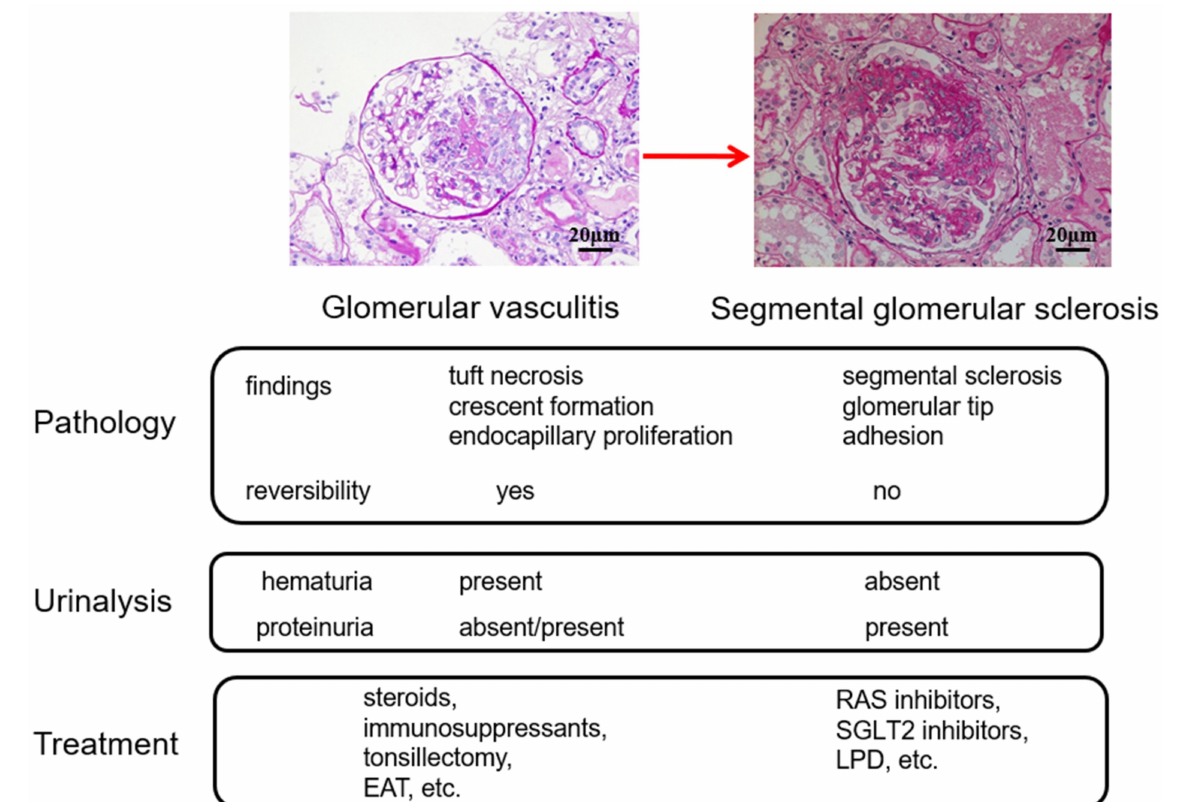
Figure 14. Treatment options based on the Glomerular vasculitis related pathologic conditions of IgAN. As Glomerular vasculitis and segmental glomerular sclerosis (SGS) differently coexist in IgAN, the key point of IgAN treatment is to estimate the element of Glomerular vasculitis and the element of the SGS from the findings of renal biopsy and urinalysis in each patient. It is also important to consider the limitation of histological assessment of Glomerular vasculitis by a limited amount of renal biopsy tissue. See the text for further details. RAS, renin-angiotensin system; SGLT2, sodium-glucose cotransporter 2; LPG, low-protein diet; EAT, epipharyngeal abrasive